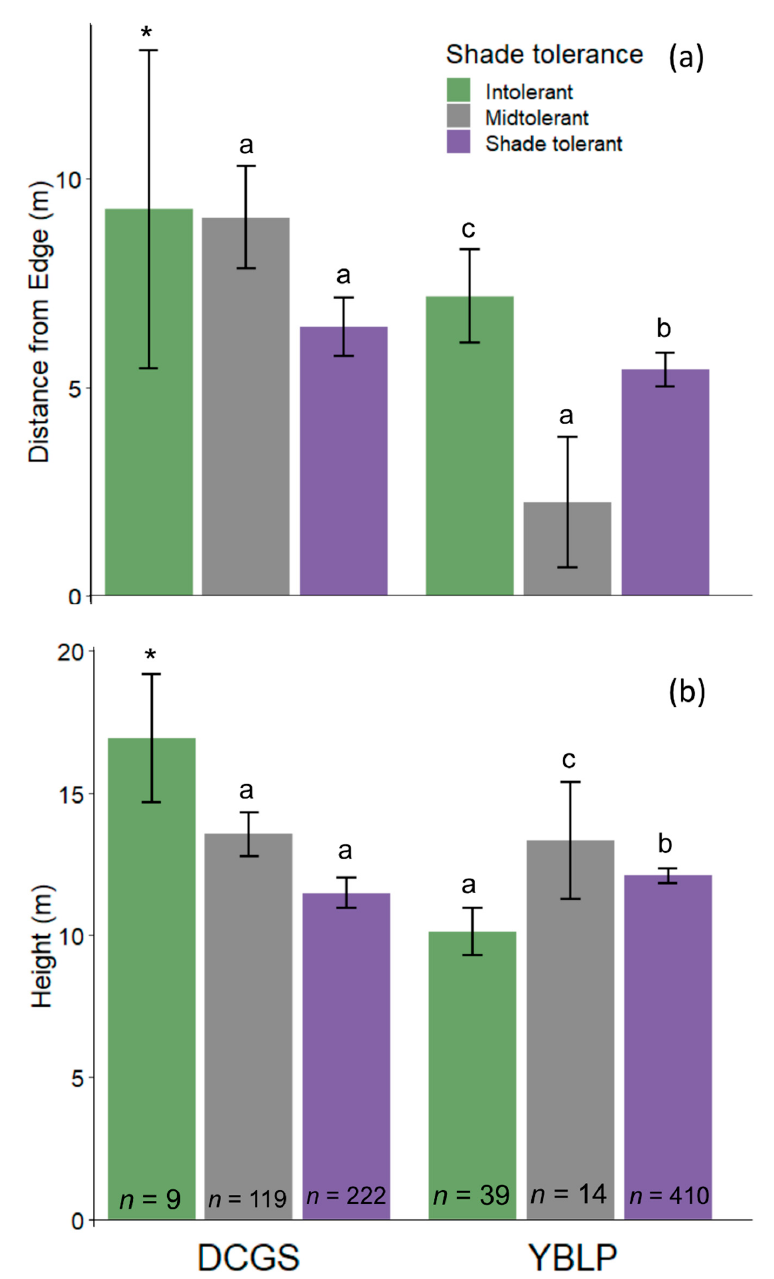
Figure 3. Bar graphs of gap-capturing sapling ( a ) distance from gap edge and ( b ) height, separated by shade-tolerance classes in two group-selection study sites in northern hardwood forests of the upper Great Lakes, USA. Bars on the left represent gap-capturing saplings from the DCGS, while those on the right represent gap-capturing saplings from the YBLP. Bar heights reflect geometric means, and error bars reflect 95% confidence intervals. Sample sizes for each shade-tolerance class are listed in panel ( b ). Lowercase letters reflect groupings from post-hoc comparisons of estimated marginal (least-squares) means from linear mixed-e ff ects models of edge, distance, or height predicted by shade-tolerance class. For DCGS models, individual canopy gaps nested within experimental blocks were used as random e ff ects, while only individual canopy gaps were treated as random e ff ects in models for the YBLP. The Benjamini–Hochberg procedure was used to adjust α = 0.05 with a false-discovery rate of 0.1 within sets of results within studies. * Shade-intolerant saplings were omitted from mixed-e ff ects models at the DCGS because of low representation ( n = 9) and uneven distribution within treatments (appearing in three of 56 canopy